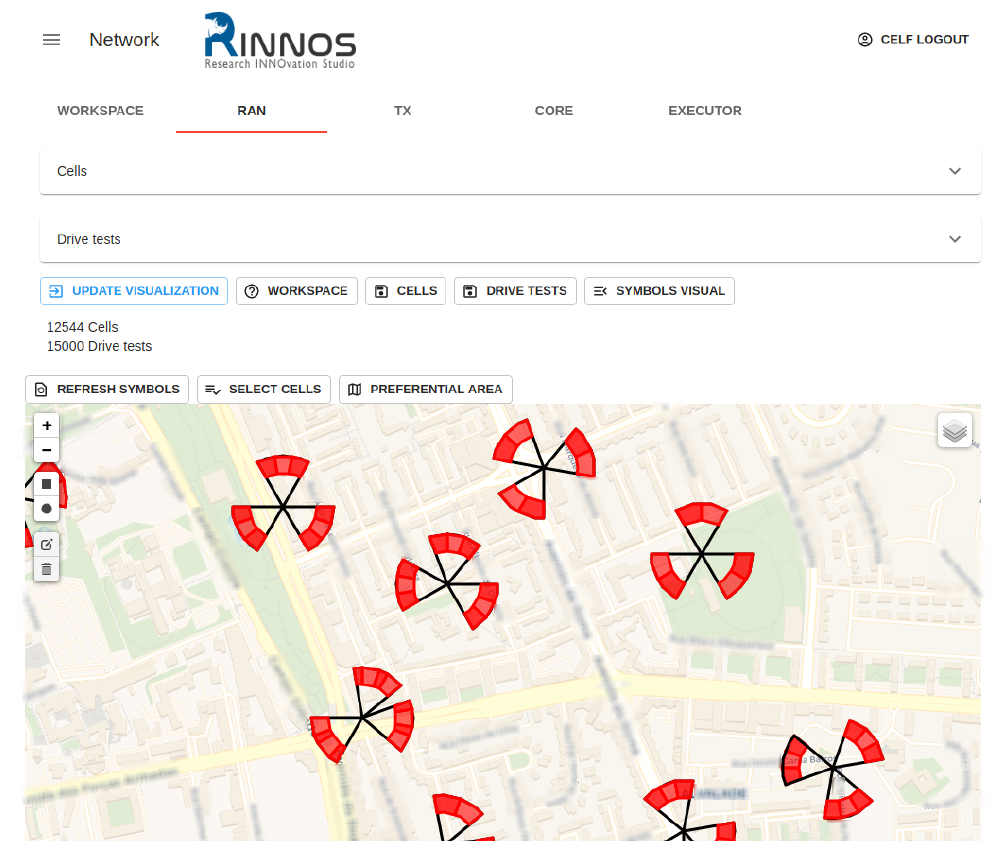
Figure 5. System overview, zoom and